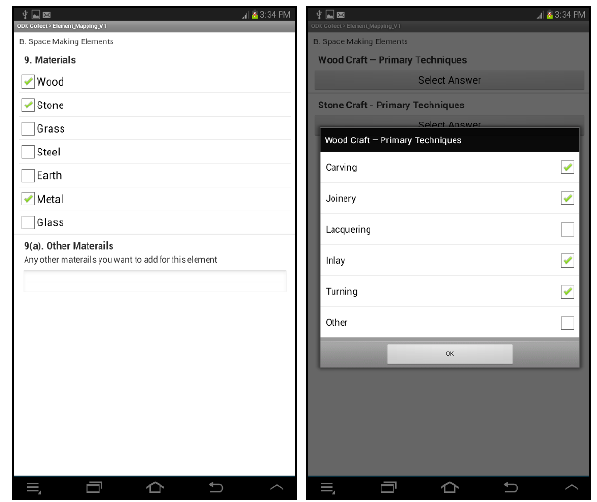
Figure 7-8. Information on the element type and condition